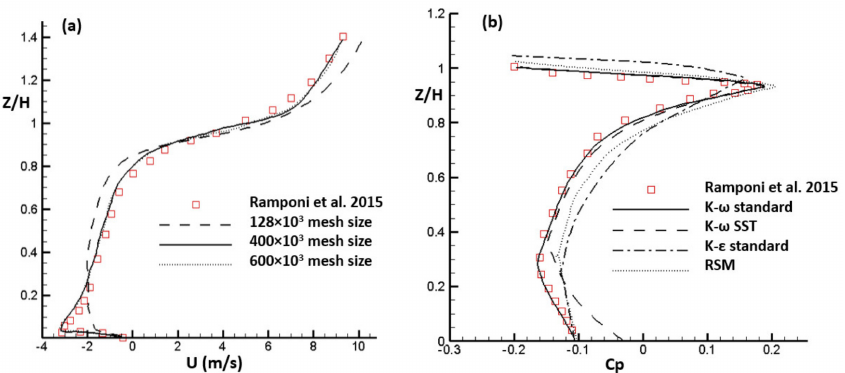
Figure 4. Wind speed and pressure coefficient validation ( a ) Vertical profile of stream-wise wind speed ( b ) Pressure coefficient.